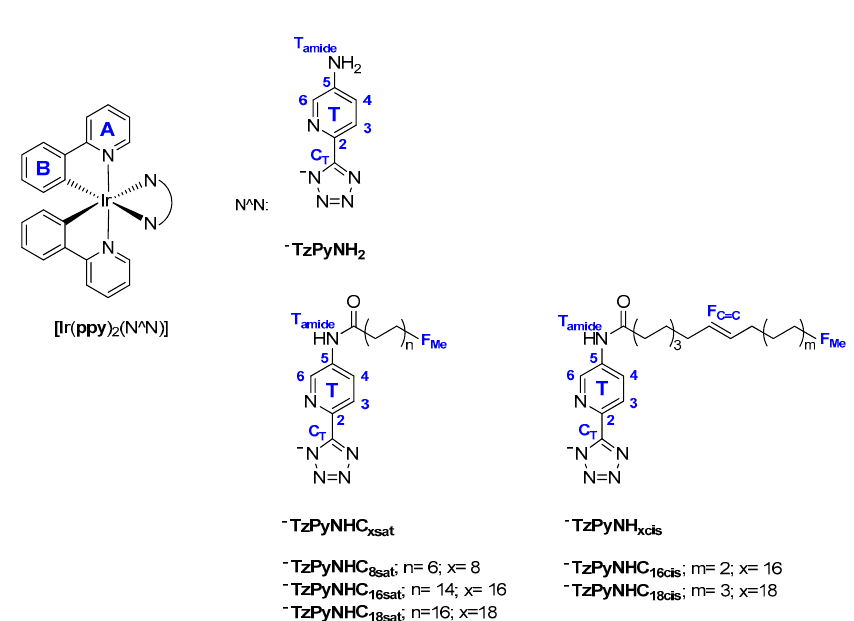
Scheme 1. Numbering system used to identify specific H and C atoms associated to their corresponding peaks in the NMR spectra.